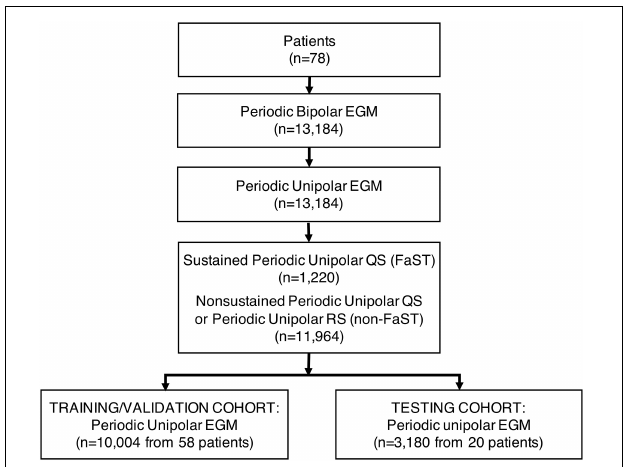
FIGURE 3 | Consort Diagram for DL Training and Testing Cohorts. Patients ( n = 78) were divided into a training/validation cohort ( n = 58) and test cohort ( n = 20). The number of periodic unipolar EGMs in each cohort is